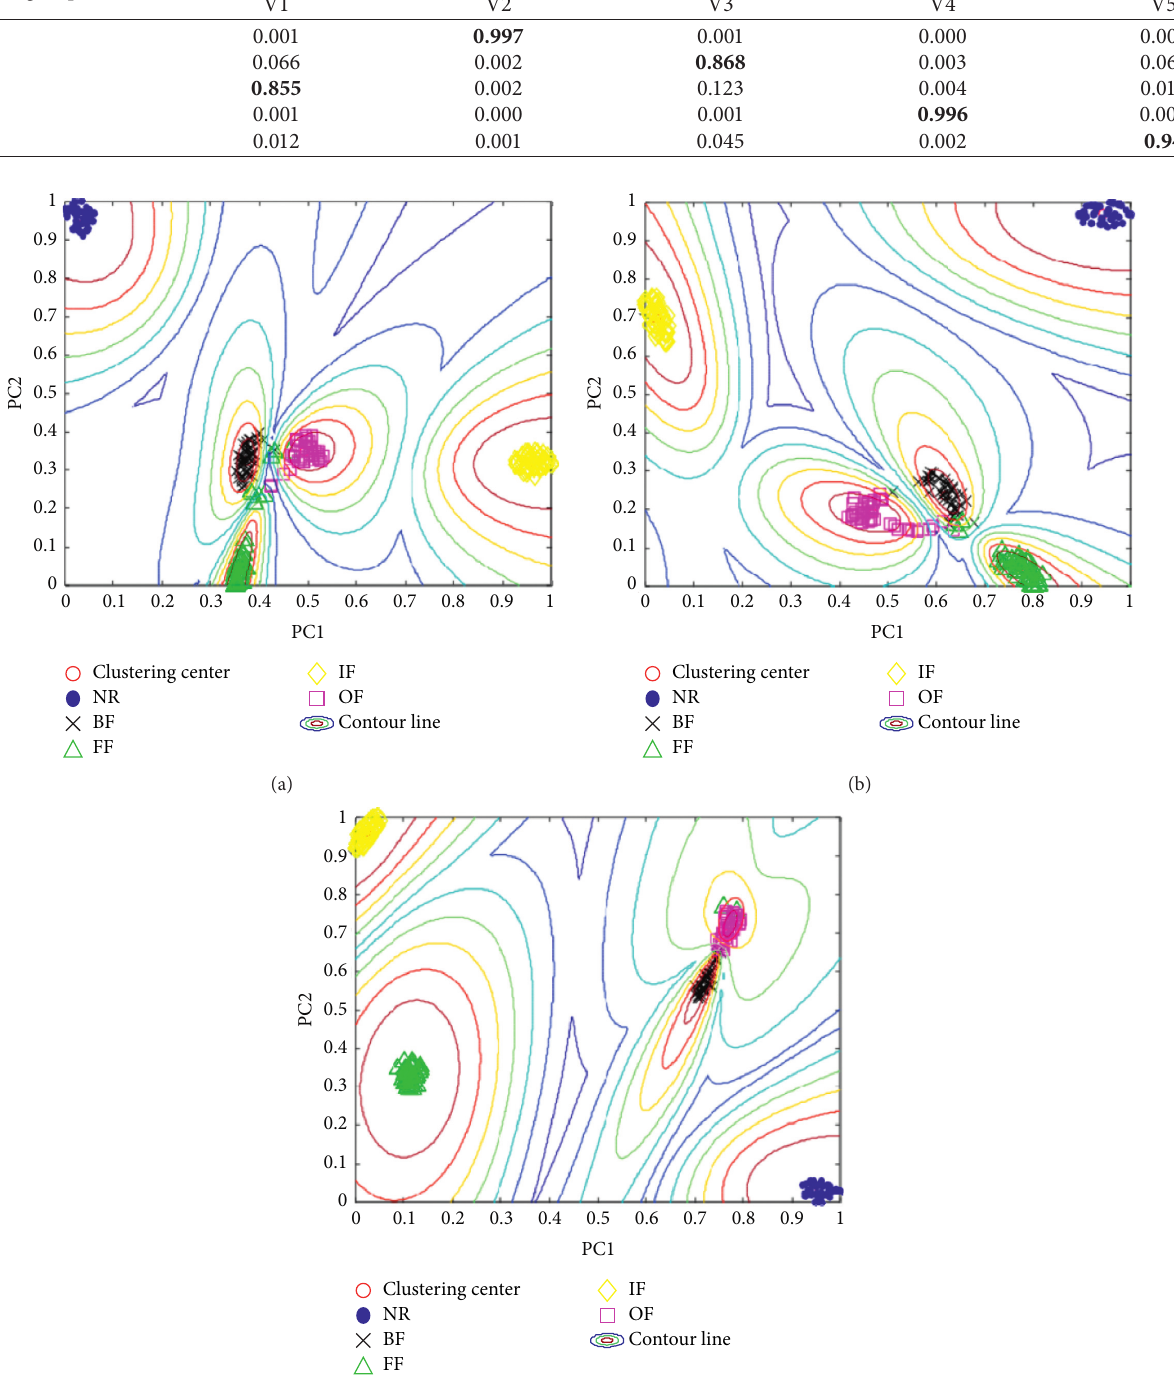
Figure 16: Recognition results at different rotating speeds. (a) 2800rpm; (b) 3000rpm; (c) 3200rpm.